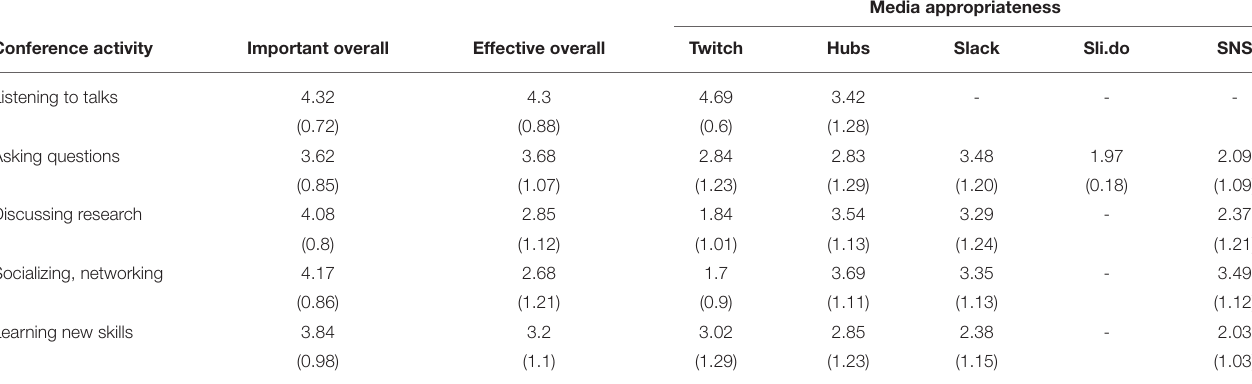
TABLE 2 | Descriptive statistics of perceptions of IEEEVR2020.